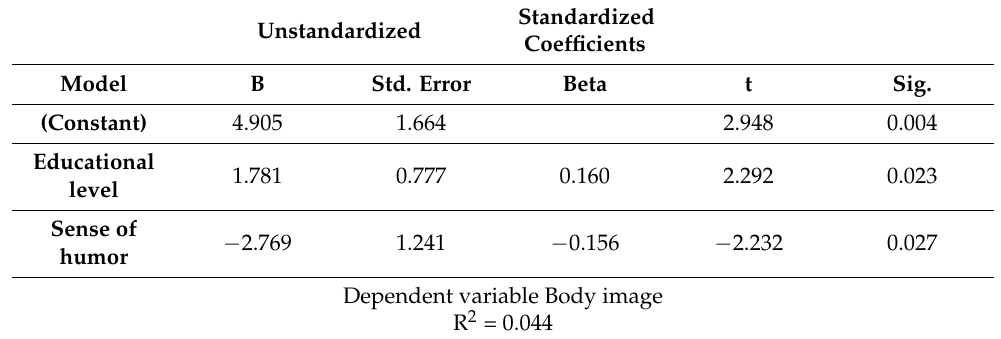
Table 3. Stepwise regression analysis between Characteristics and Body Image and Self Esteem in Breast Cancer Survivors. Standardized Unstandardized